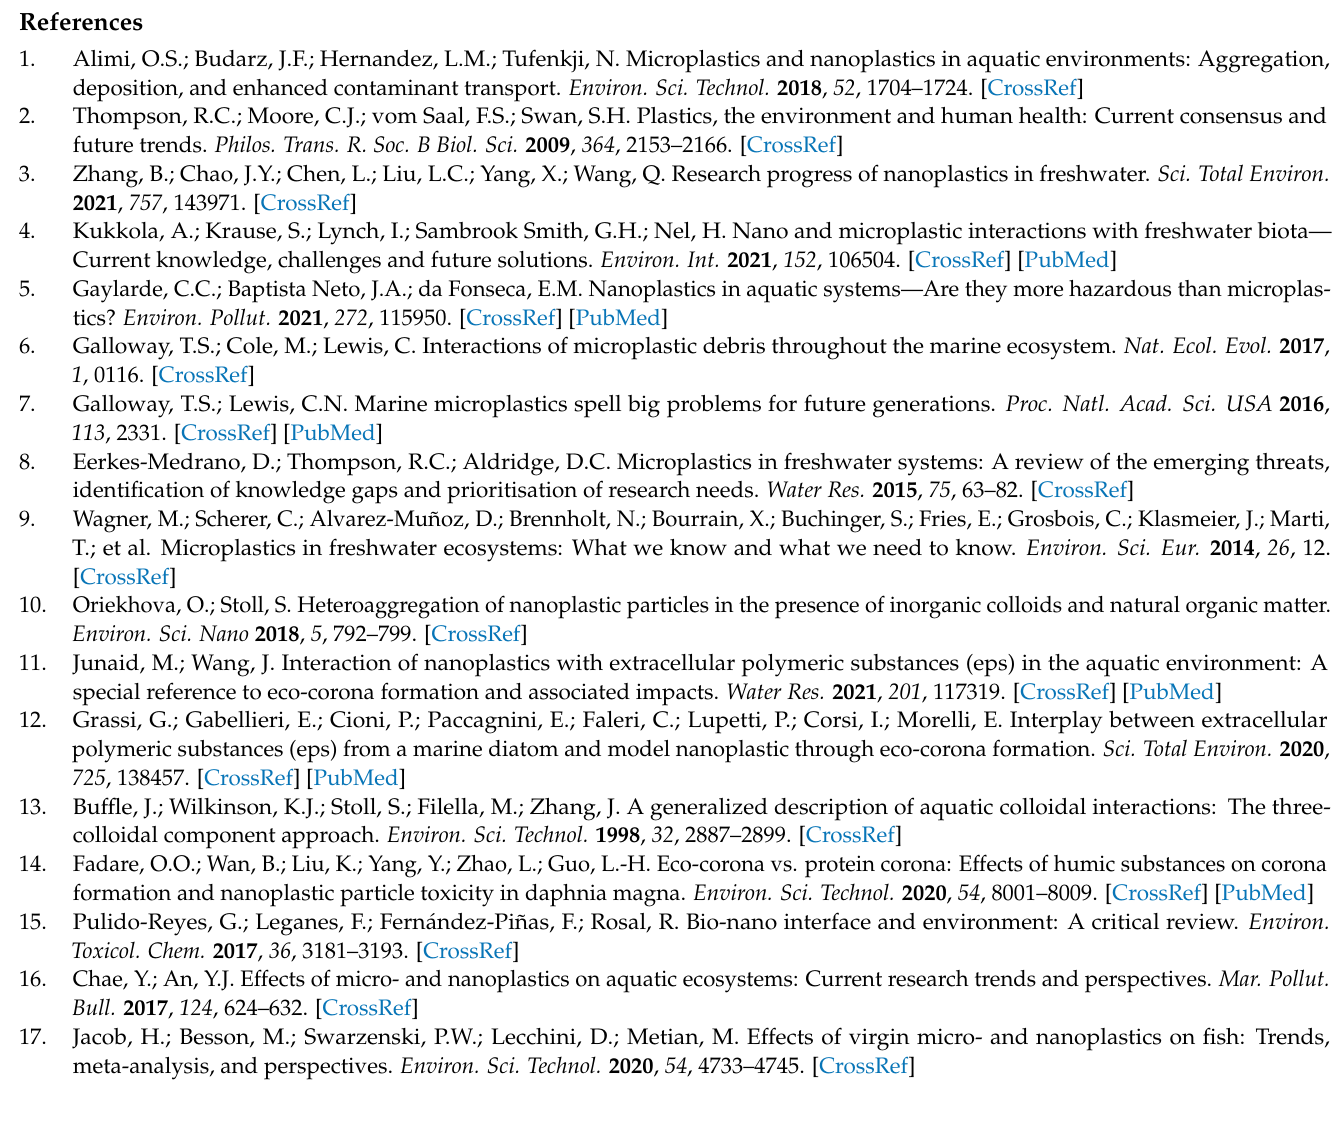
Table S1: Characteristics of 20, 40, 60, and 100 nm polystyrene nanoplastics (NPLs) as provided by the manufacturer, Table S2: Ionic compositions and DOC of freshwaters sampled from Station 1 to Station 5 of transect Pointe- à